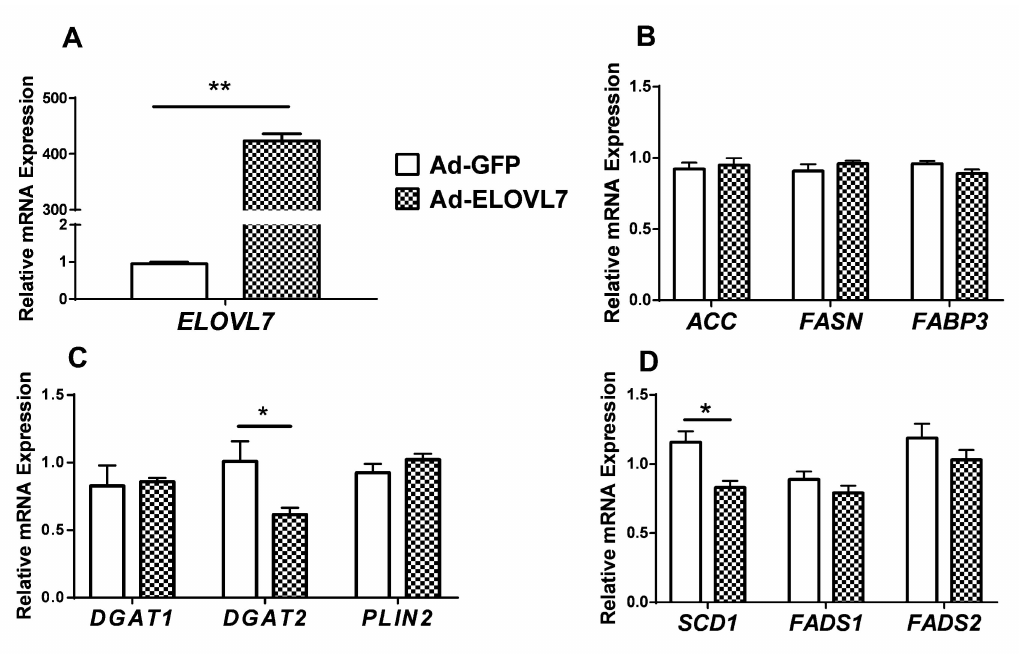
Figure 2. Overexpression of elongation of very-long-chain fatty acid-like fatty acid elongase 7 ( ELOVL7 ) altered gene expression. Goat mammary epithelial cells (GMEC) were transfected with Ad-ELOVL7 or Ad-GFP for 48 h and then collected for mRNA extraction. Panel A: mRNA expression of ELOVL7 . Panel B: mRNA expression of genes related to de novo synthesis ( ACC and FASN ) and transport ( FABP3 ). Panel C: mRNA expression of genes related to triacylglycerol synthesis ( DGAT1 , DGAT2 , and PLIN2 ). Panel D: mRNA expression of genes related to desaturation ( SCD1 , FADS1 , and FADS2 ). Values are means ± SEM from 3 individual cultures. * p < 0.05 compared with control (Ad-GFP). The data were determined via Student’s t-test. Significance was declared at p <